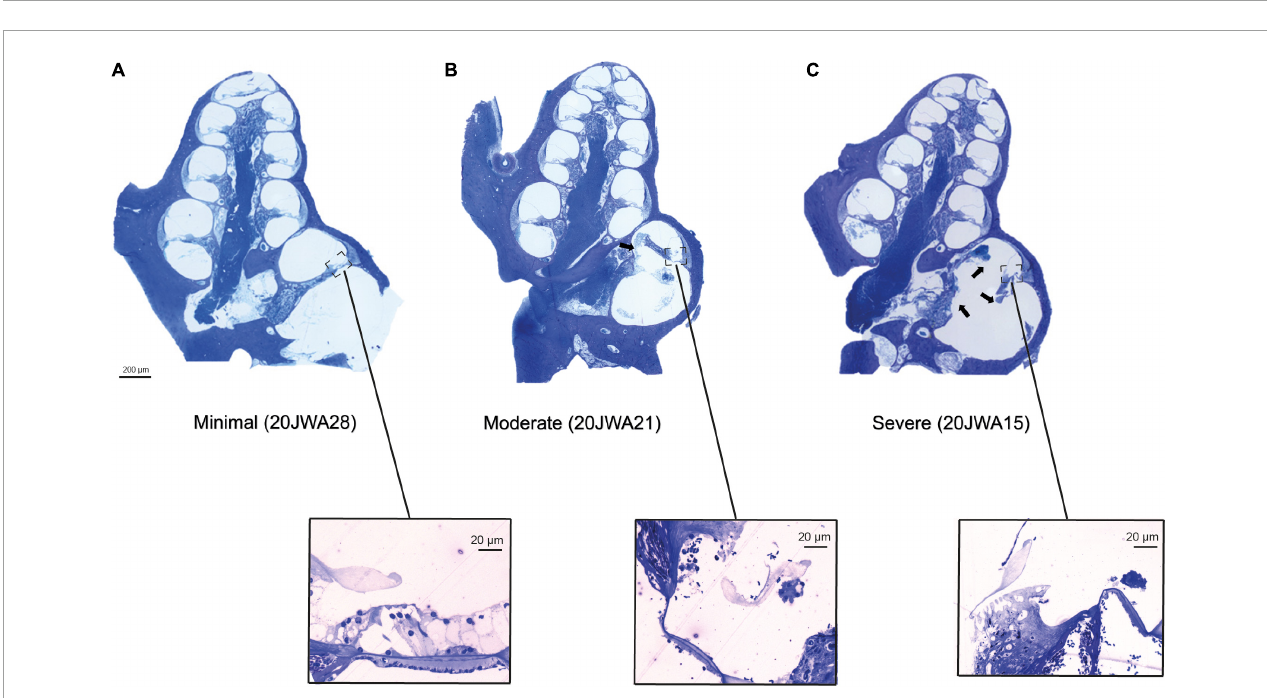
FIGURE5 Three midmodiolar section examples (2.5x, light microscopy) are shown of each trauma group. In the minimal trauma group (A) , no other trauma than the cochleostomy was observed. In the moderate trauma group (B) , a fracture of the osseous spiral lamina is clearly seen in the basal turn (arrow). In the severe trauma group (C) , in addition to fracture of OSL, the modiolar wall is damaged at the basal turn. Additionally, the organ of Corti of the lower basal semiturn is shown at greater magnification (25x): (A) intact organ of Corti with 3 outer hair cells and one inner hair cell; (B) absent inner and outer hair cells; (C) absent inner and outer hair